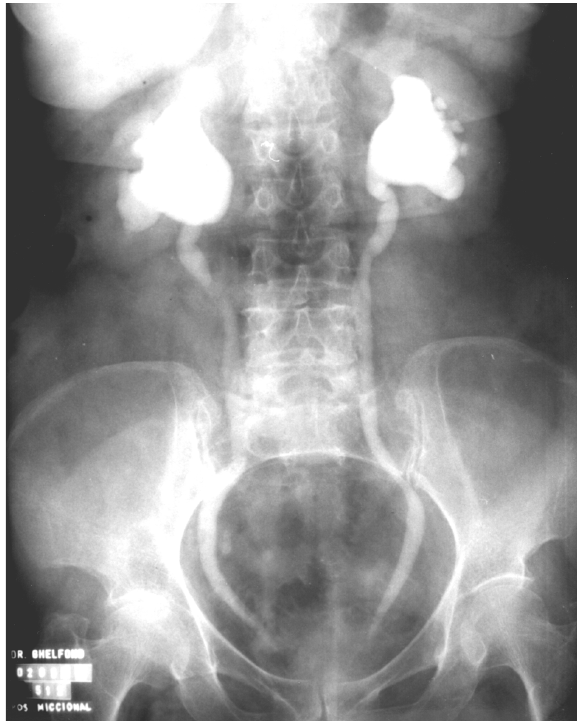
Figure 2 – Excretory urography evidencing bilateral hydroneph- rosis due to vaginal